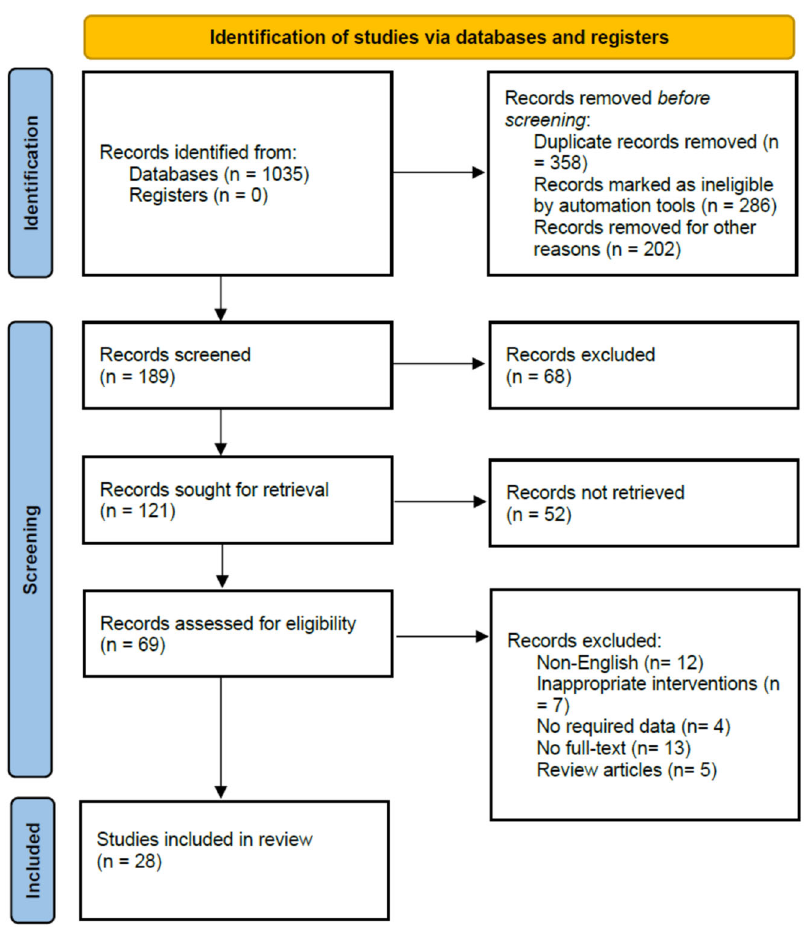
Figure 1. Flowchart of included studies. Table 1. Characteristics of eligible studies conducted in Saudi